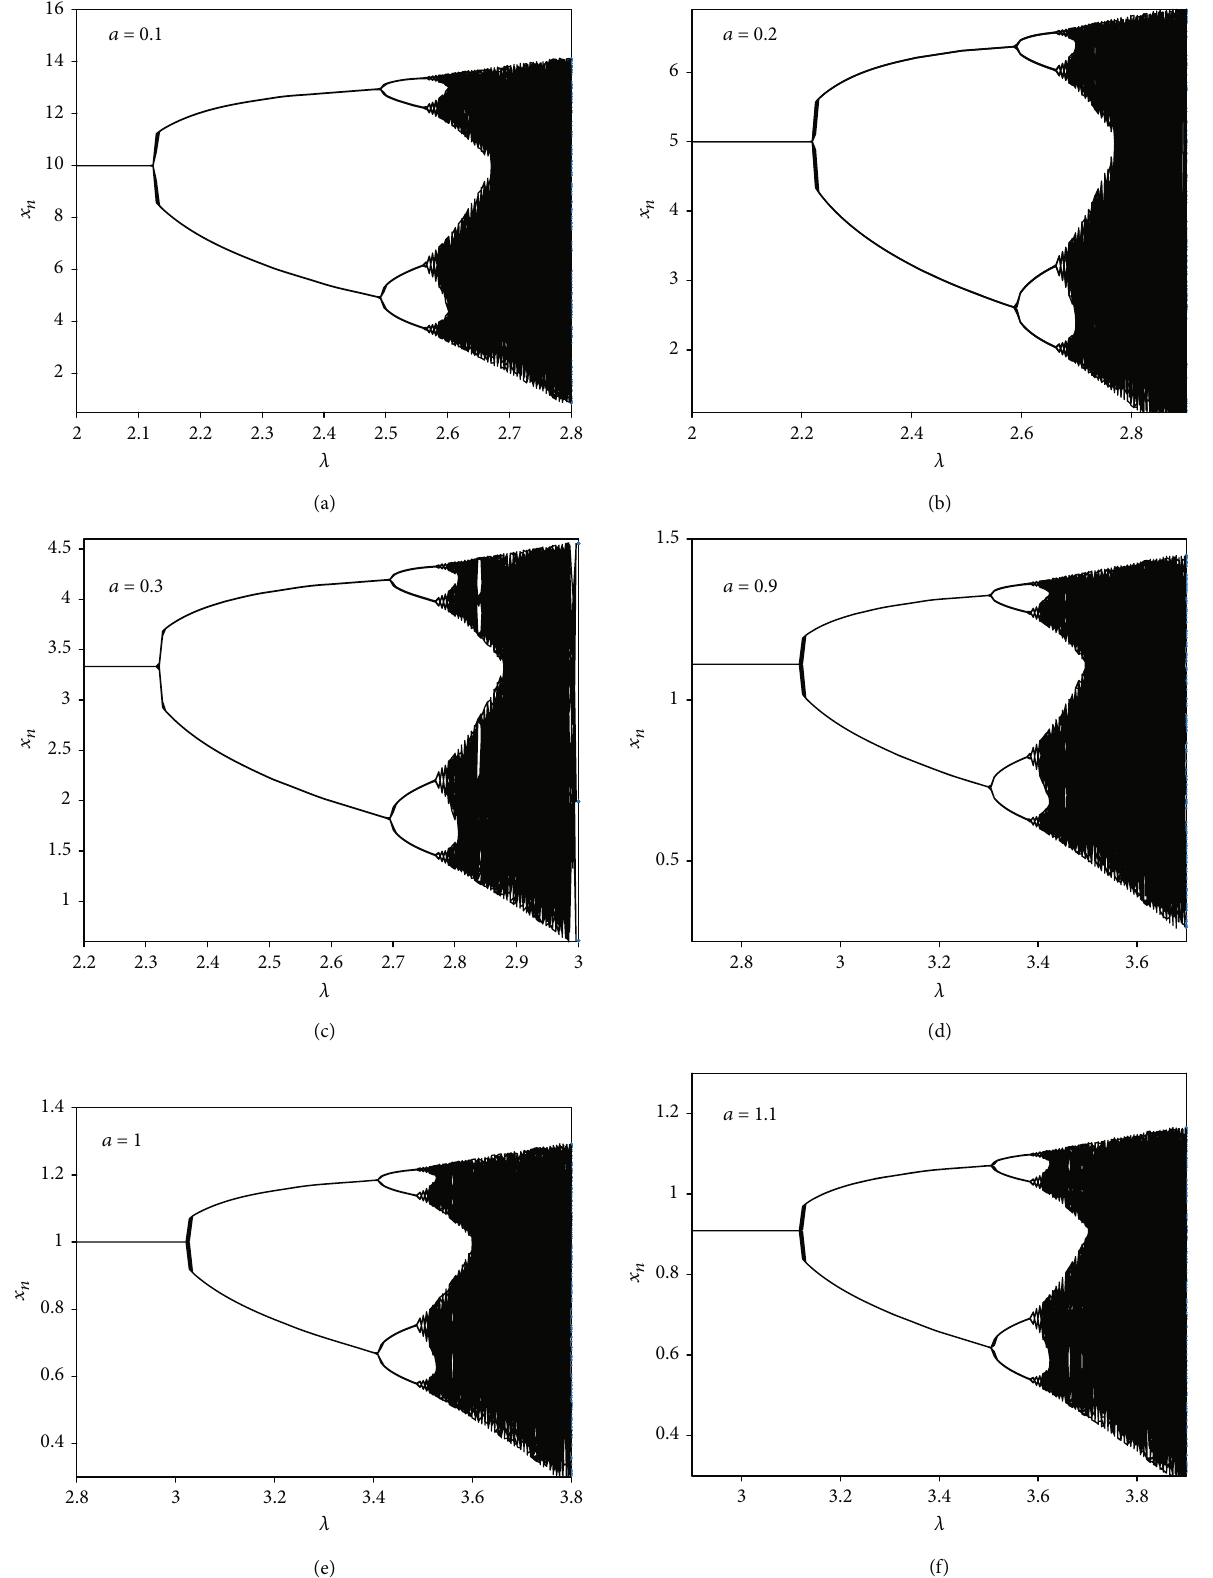
Figure 2: Bifurcation diagrams for a = 0 : 1 , a = 0 : 2 , a = 0 : 3 , a = 0 : 9 , a = 1 , and a = 1 : 1